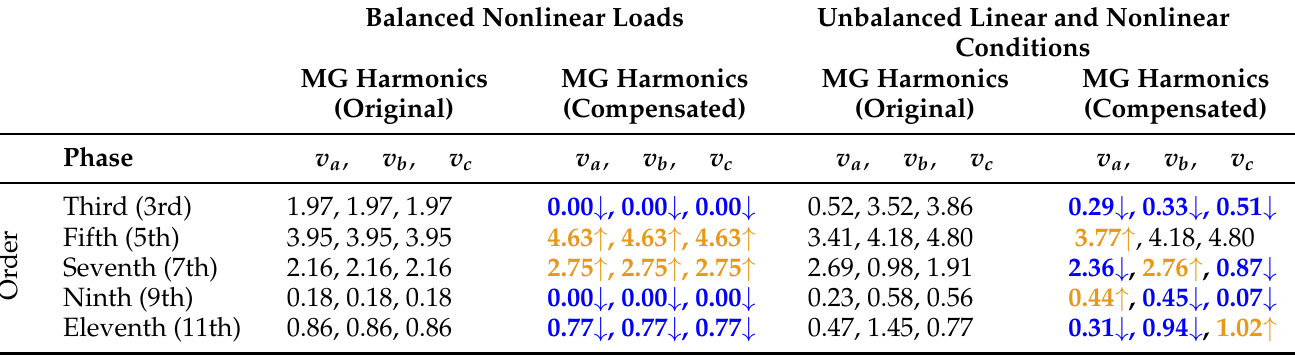
Table 8. Harmonics attenuated by the hybrid PI-LQR controller tuned with PSO, for the second (Columns 2 and 3) and third (Columns 4 and 5) testing scenarios. Harmonics mitigated are shown in blue, while those that were aggravated are shown in